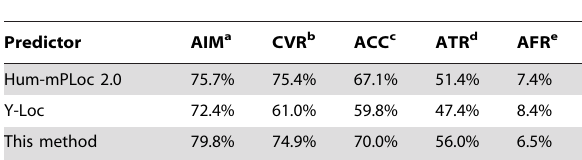
Table 1. Comparison of prediction